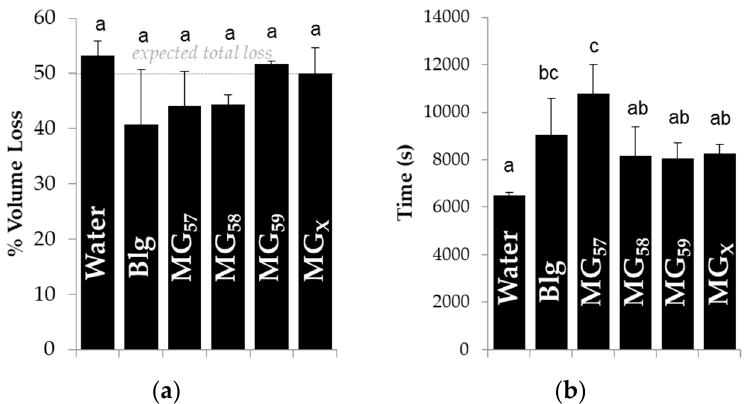
Figure 7. Effect of Blg microgel size and cross-linking treatment on ( a ) total volume loss from a pendant droplet containing 50% ( v / v ) 1-hexanol and ( b ) time to achieve total volume loss. Letters above data denote groups of data that were not significantly different as a function of different treatment.